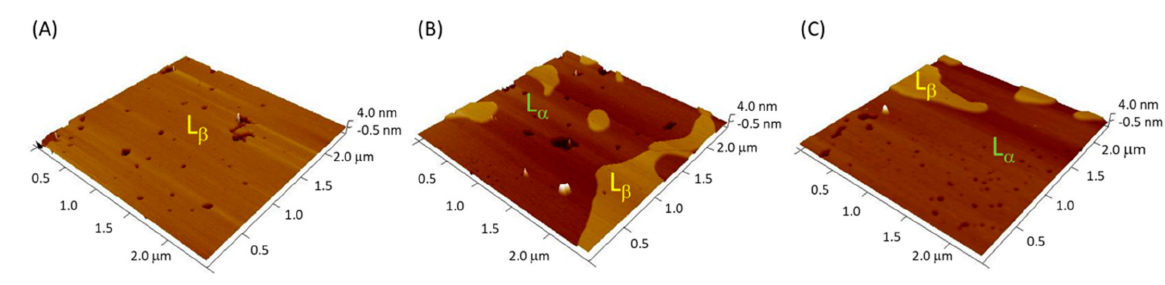
Figure 3. Atomic force microscopy (AFM) images collected for DPPG/POPG/CL bilayer deposited on mica before ( A ) and after ~30 min of the exposure to LC10-OP ( B ) and BC10-OP ( C ). The images were recorded in aqueous 0.01 M